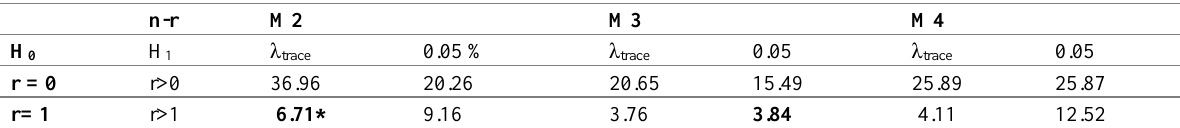
Table 4: Case 1- LNTHE and LNGDP